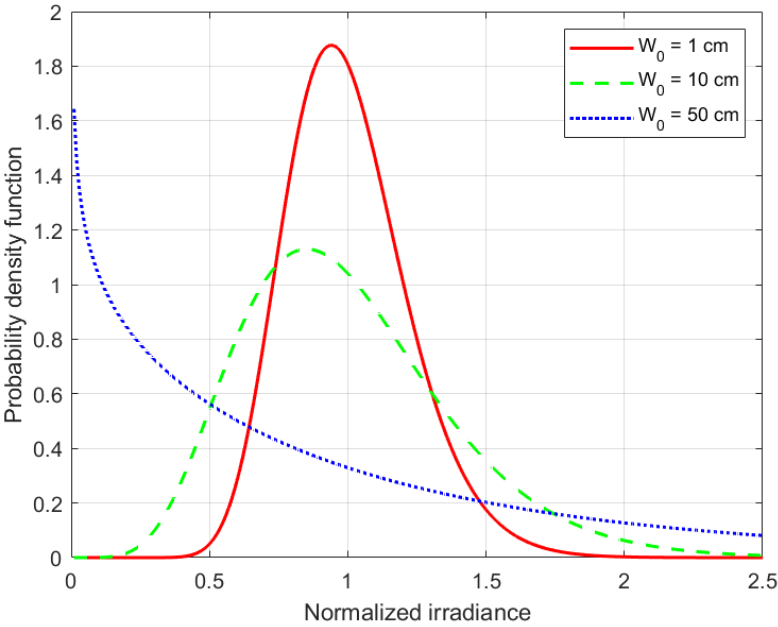
Figure 7. Gamma-Gamma probability density function for an untracked collimated beam plotted as a function of the normalized irradiance for a GEO optical feeder uplink channel with zenith angle ζ = 0 deg. and H-V 5/7 refractive index structure ( λ = 1.55 µ m, r 0 = 19cm). Beam radius: W 0 = 1cm (solid red lines), W 0 = 10cm (dashed green lines), and W 0 = 50cm (dotted blue